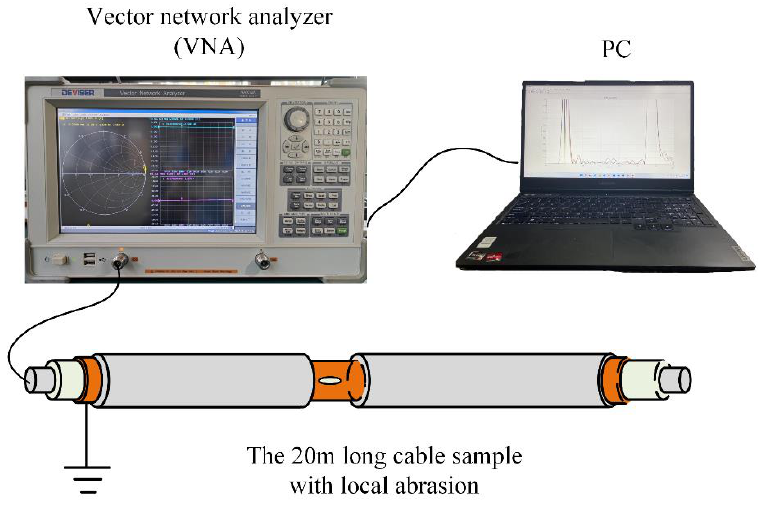
Figure 6. Experimental platform setup.